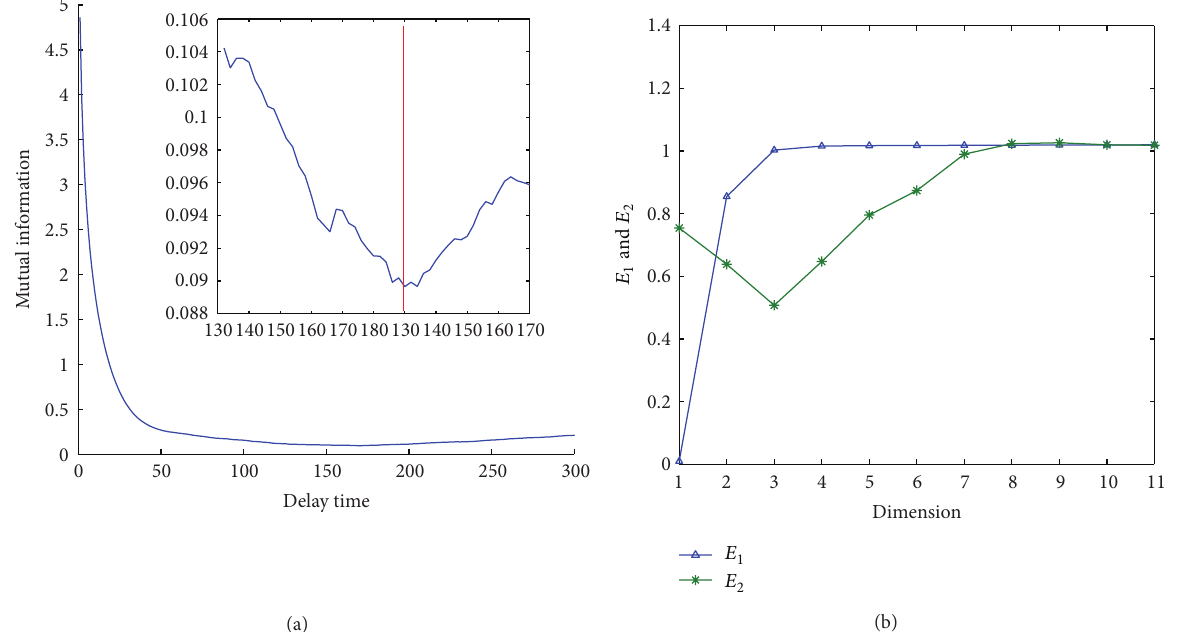
Figure 4: Determination of the proper delay time and embedding dimension of the longitudinal vibration ( 𝜏 = 160 , 𝑑 = 8 ).